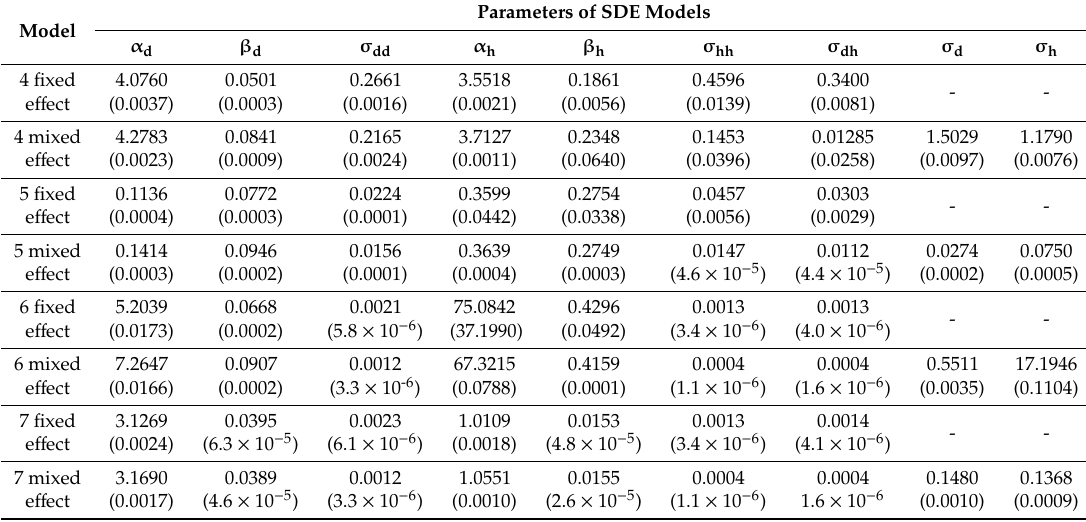
Table 6. Estimates of parameters and their standard errors (in parenthesis) for all fitted bivariate SDE